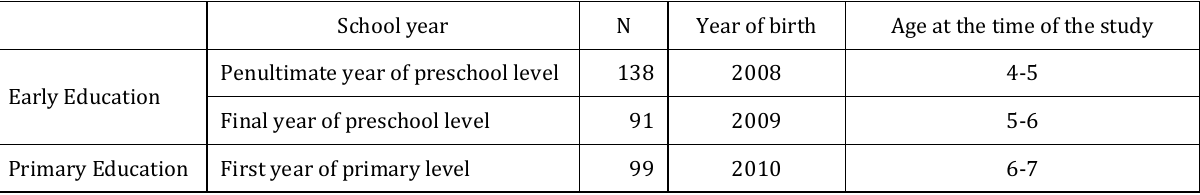
Table 1. Composition of the sample according to the educational level of the